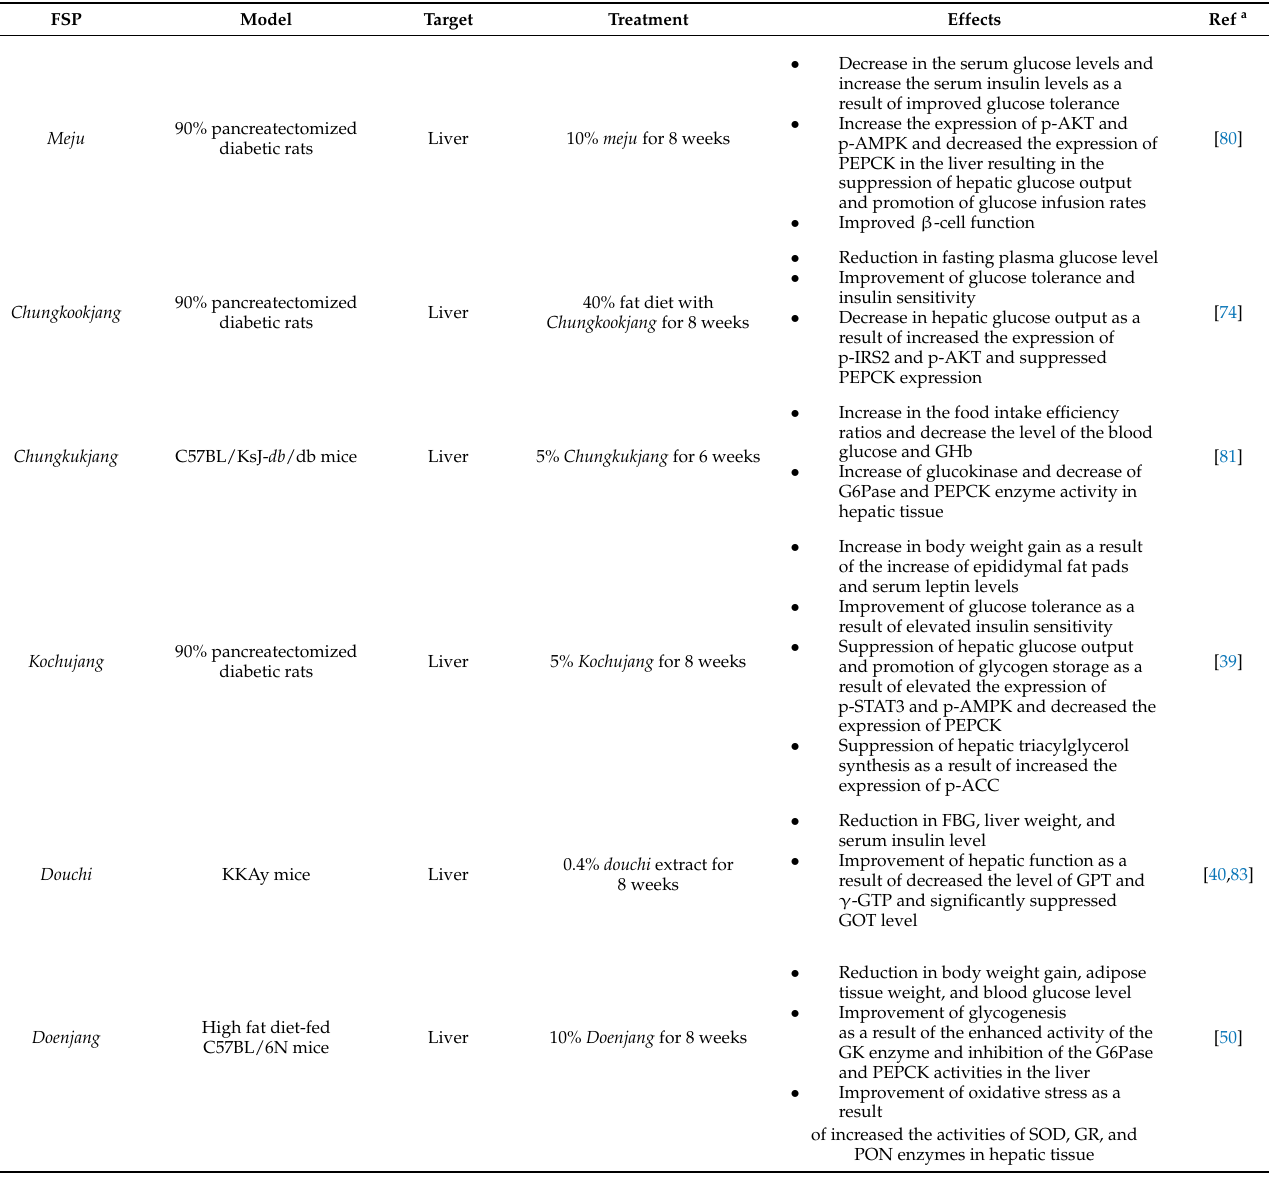
Table 4. The mechanisms of modulating the effect of FSP on glucose homeostasis in liver